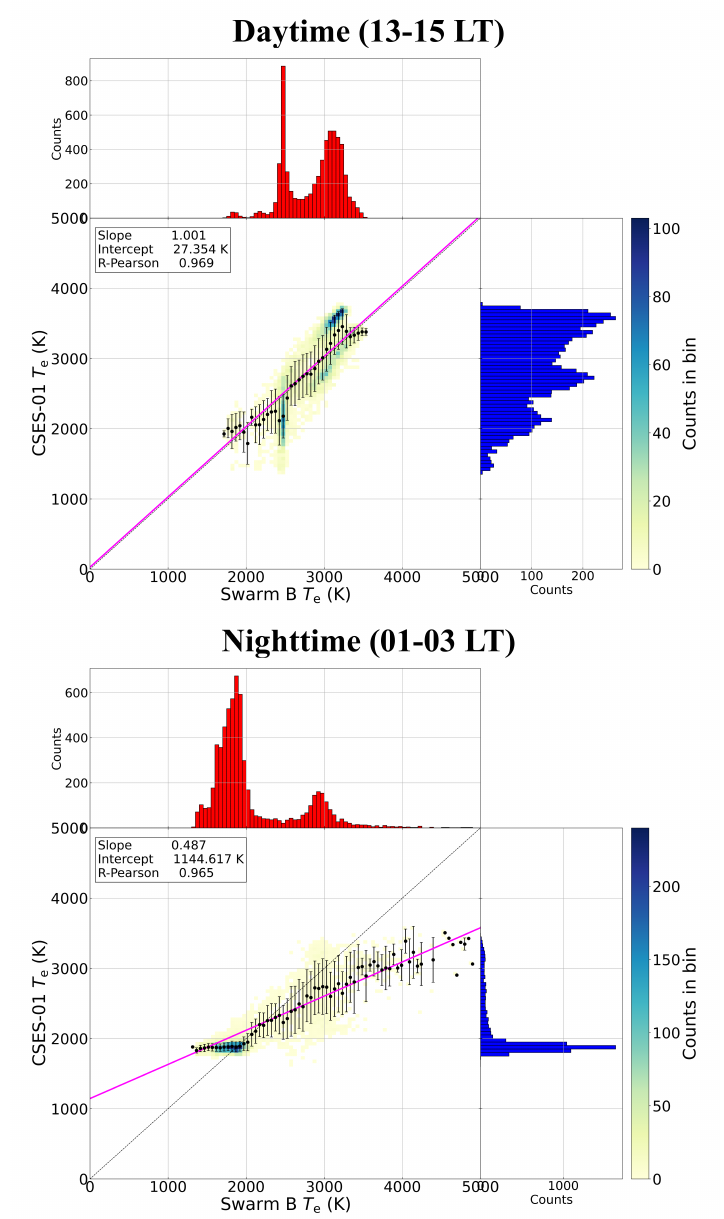
Figure 6. Joint probability distributions between CSES-01 ( y -axis) and Swarm B ( x -axis) T e mean values represented in Figure 5. Top panel refers to the daytime sector (13–15 LT), bottom panel to the nighttime sector (01–03 LT). In each panel, histograms of the counts are also reported: on the right and in blue for CSES-01; on top and in red for Swarm B. The black circles refer to the mean values of CSES-01 T e conditioned by Swarm B T e , with error bars as the standard deviation. The magenta line is the linear fit on black points, with coefficients given in the legend. Dashed black line denotes the first-third quadrant